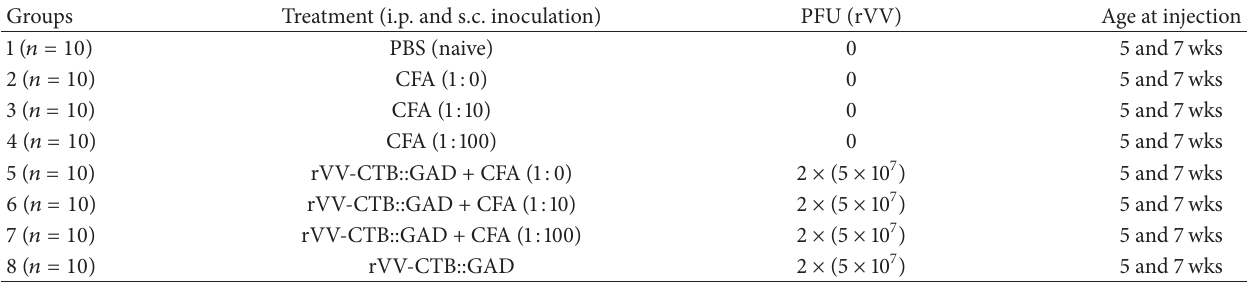
Table 1: NOD mouse treatment groups for rVV-mediated suppression of hyperglycemia.